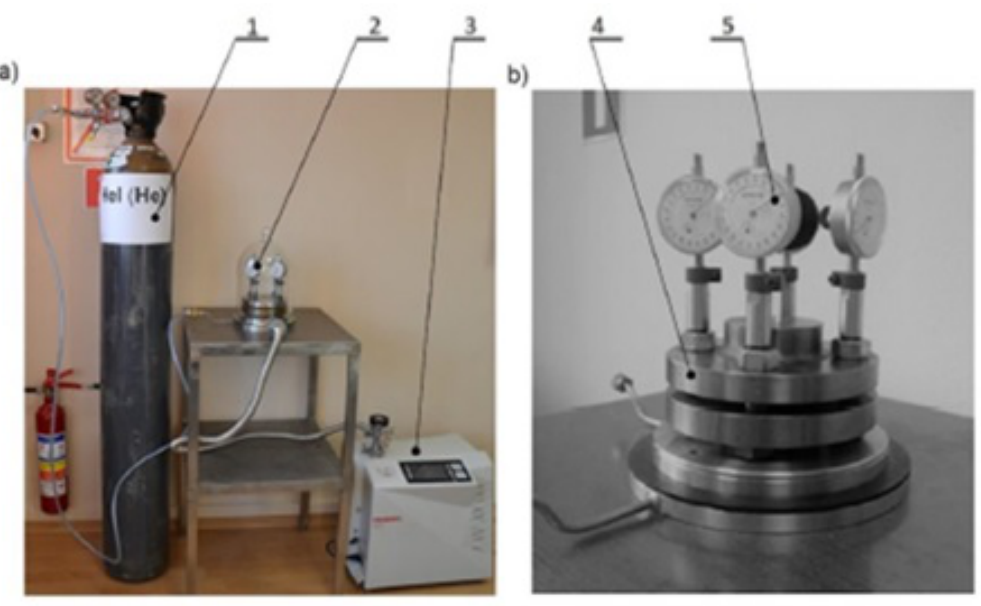
Figure 15: Test rig for the leakage test: 1- helium reservoir, 2-glass cover, 3 – helium detector, 4- flange bolted joint with gasket, 5 micromet- ric measuring